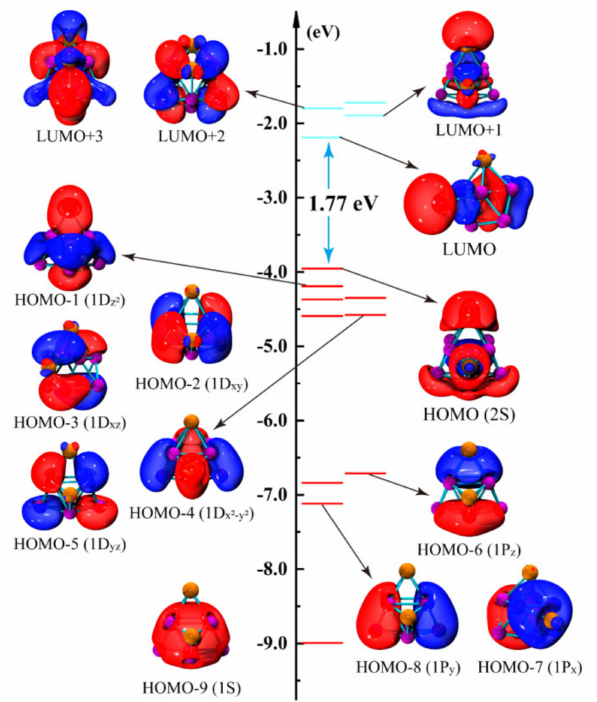
Figure 5. Molecular orbitals and the corresponding energy levels of the Ca 2 Mg 8 cluster. The HOMO– LUMO gap is indicated (in